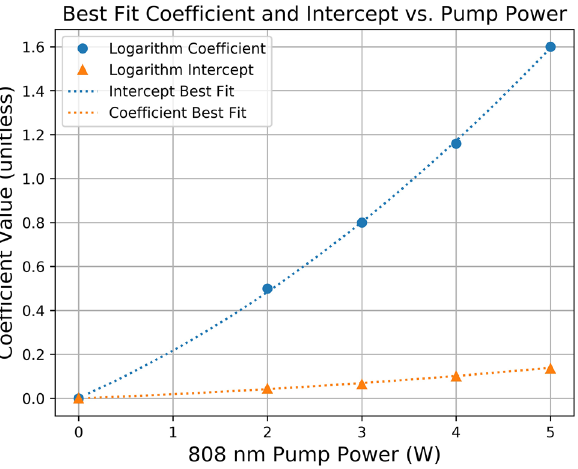
Figure 7. The coefficient and intercept values for the 532 nm logarithmic relation derived using experimental data for maximum SHG power vs. PPLN